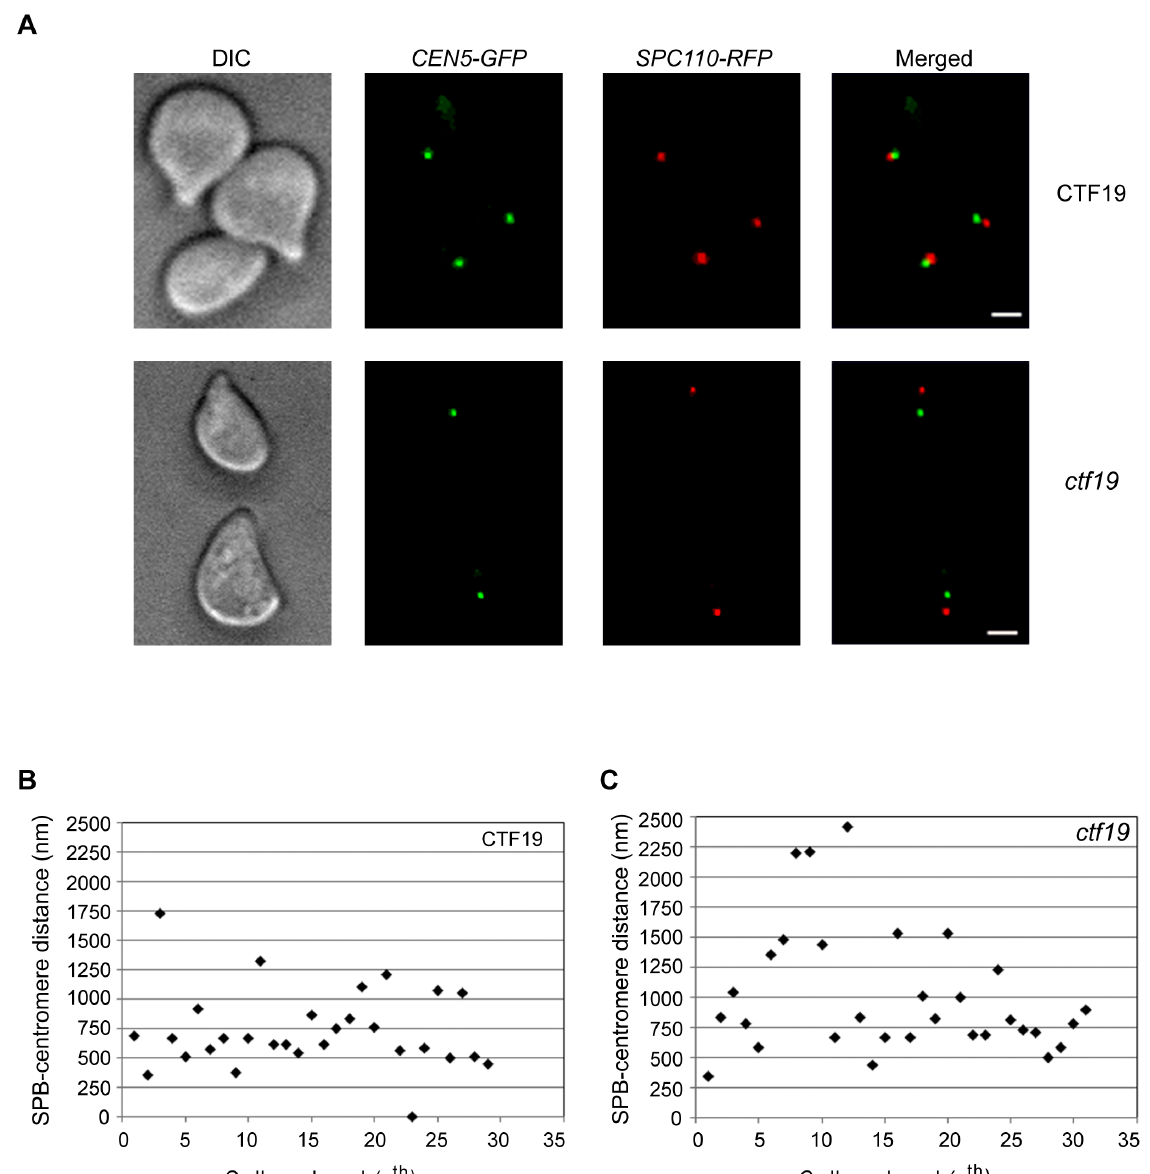
Figure 3. ctf19 cells show increased average SPB-centromere distance at G1. PS1 (wild-type) and PS1 D ctf19 ( ctf19 ) cells were arrested at G1 using a -factor (10 m g/ml) for 120 minutes and fixed with 4% paraformaldehyde (PFA) for 10 minutes at RT. At least 20 z-sections of 0.25 m m were imaged. (A) G1 cells from PS1 (upper panel) and PS1 D ctf19 (lower panel) are shown. Yellow or partial yellow indicates overlapping of SPB (Spc110p- RFP) and centromere ( CEN5 - GFP ). Scale bars, 2 m m. (B) The 3D distance between SPB and CEN5 was measured in G1 arrested cells and plotted. 29 cells of the wild-type and 30 cells of the mutant were analyzed.